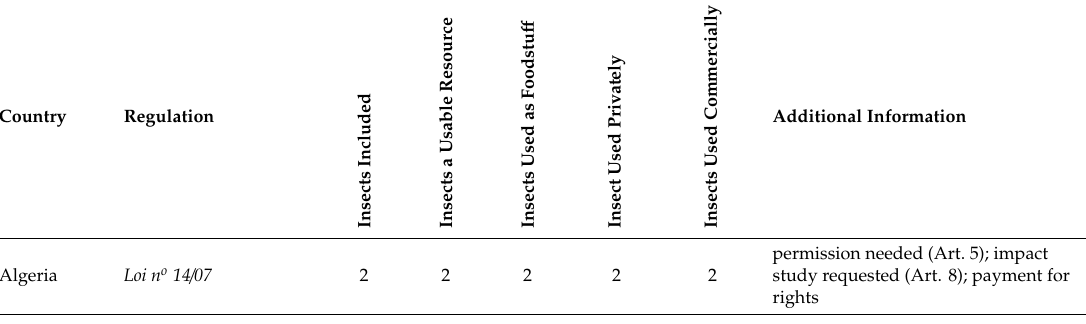
Table 5. Summary of the references towards edible insects within African wildlife management legislation; numbers refer to the specific article of the regulation in question; for Cape Verde, Namibia, Seychelles, Somalia, South Sudan, and Zambia, regulations’ definitions were not applicable to